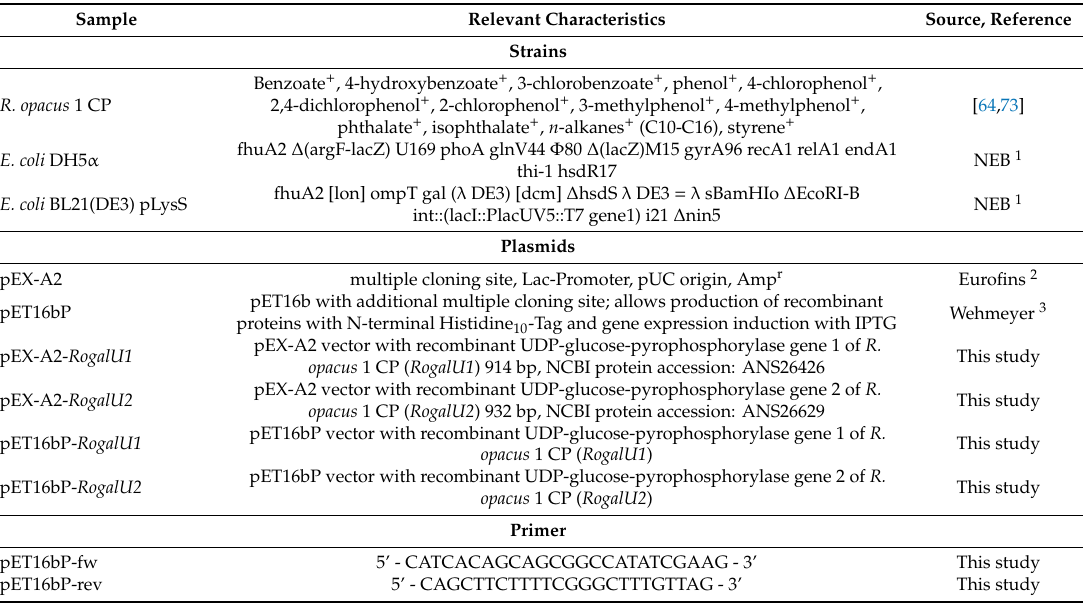
Table 3. Strains, plasmids, and primers used in this